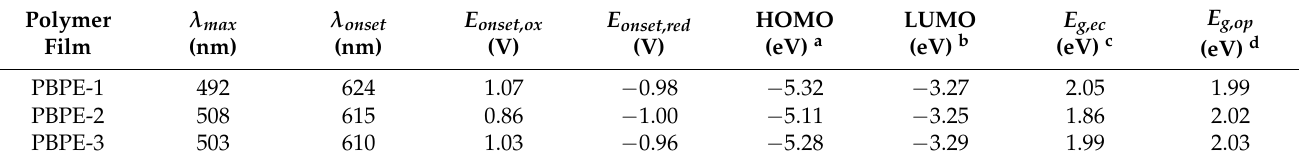
Table 1. Parameters of the optical and electrochemical properties of three polymers.